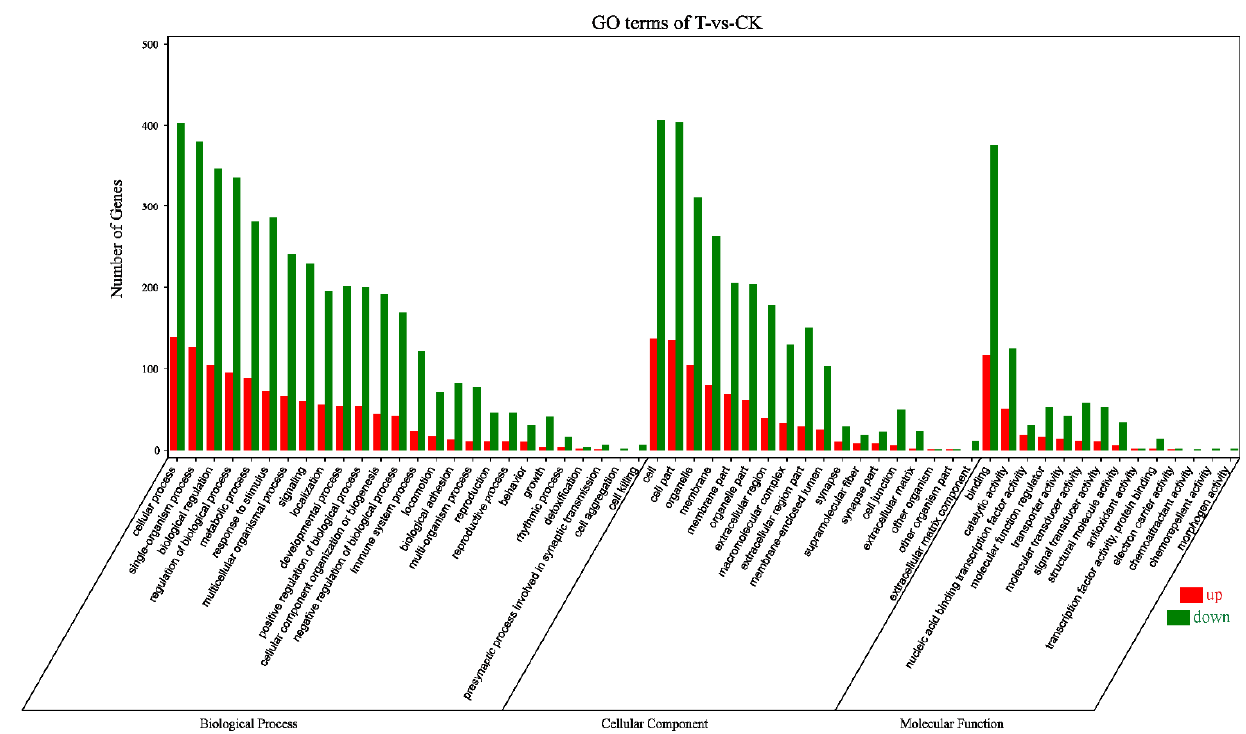
Int. J. Mol. Sci. 2021 , 22 , x FOR PEER REVIEW Figure 6. Gene Ontology terms categorization of 681 DEGs. Number of genes: number of target genes in a term. Red, upregulation; green, downregulation; CK, the control group; T, the naringenin group.